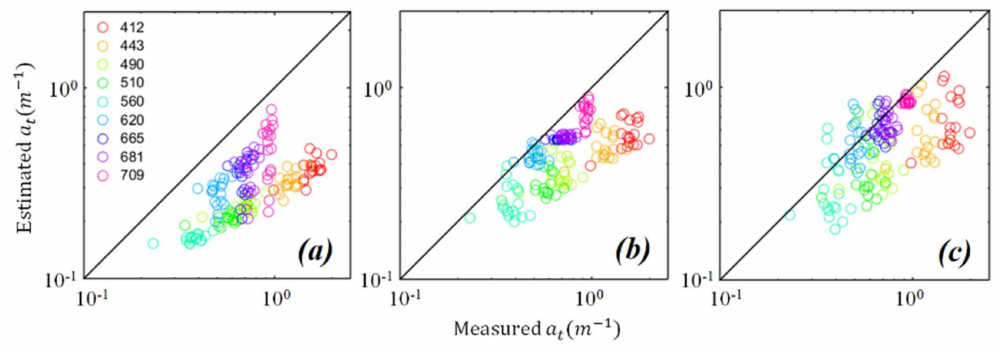
Figure 3. Relationship between estimated and measured a t ( λ ) using existing quasi-analytical algorithms (QAAs): ( a ) QAAL v5 ; ( b ) QAAL v6 and ( c ) QAA M14 . The colored circles represent the band centers of the OLCI